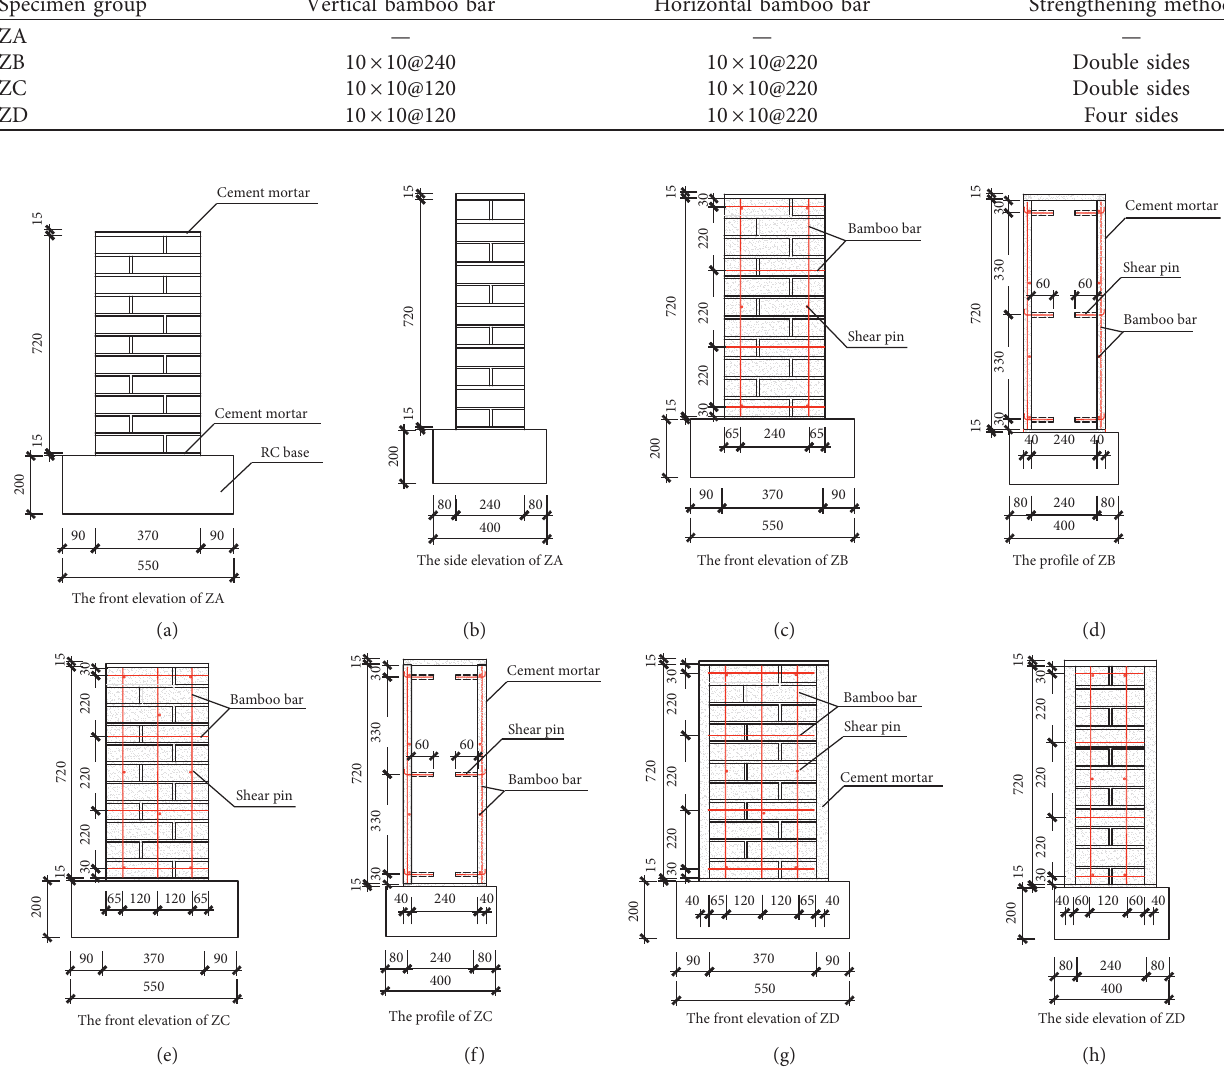
Figure 1: Schematic diagram of specimens.(a) The front elevation of ZA. (b) The side elevation of ZA. (c) The front elevation of ZB. (d) The profile of ZB. (e) The front elevation of ZC. (f) The profile of ZC. (g) The front elevation of ZD. (h) The side elevation of ZD.